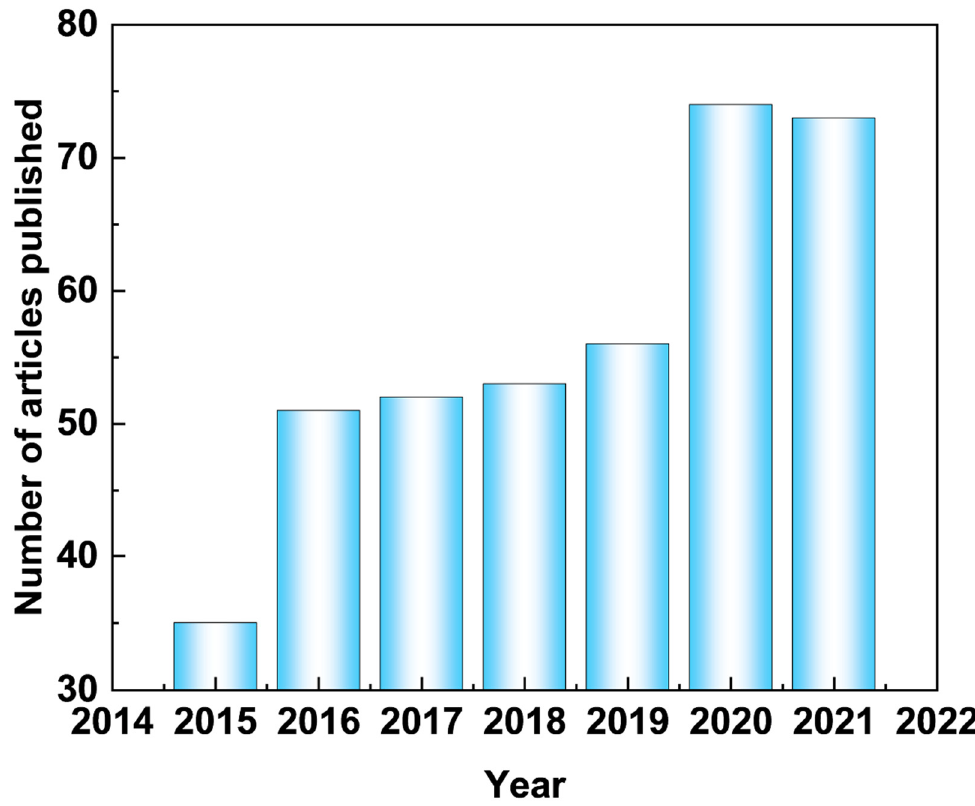
Figure 1. Statistical publications indexed in the web of science by using the term “Superhydrophobic” and “Magnesium alloy”. The number of publications from 2015 to 2021.